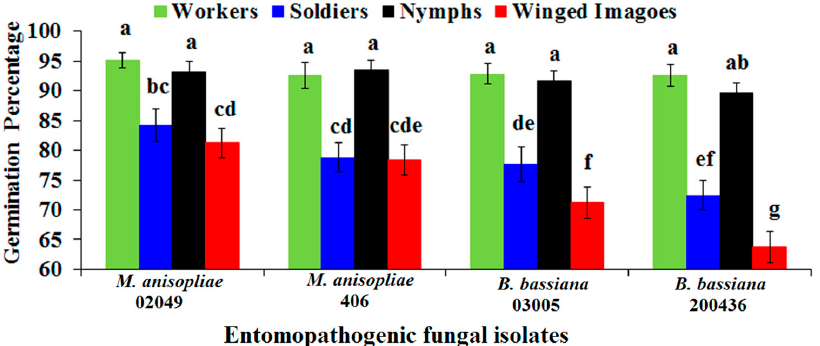
Figure 2. Percent germination of the conidia of entomopathogenic fungal isolates on the cuticle of workers, soldiers, nymphs and winged imagoes. Values are the means of five replicates. Mean ± SE values followed by different letter(s) are significantly different (Fisher’s LSD test, α = 0.05).